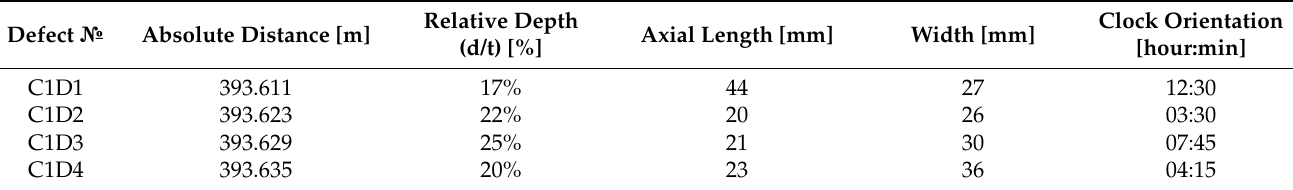
Table 1. Anomaly dimensions in cluster 1. Source: Author’s analysis.